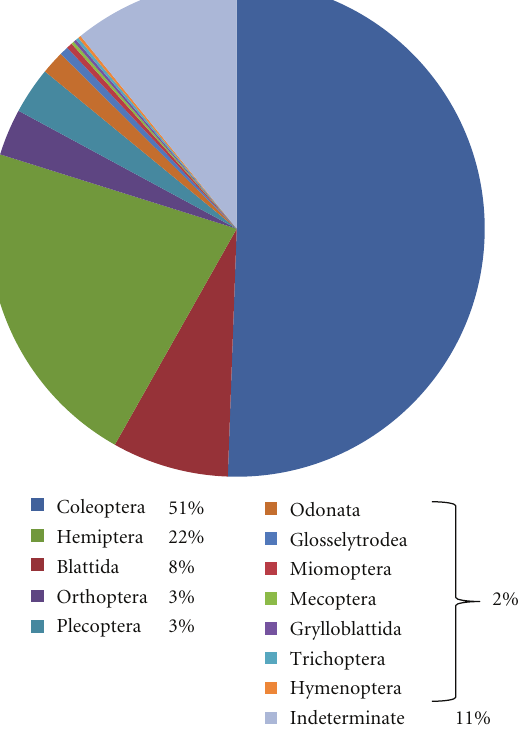
Figure 1: Pie-chart showing the abundance of Mesozoic specimens from Argentina, grouped by taxonomic